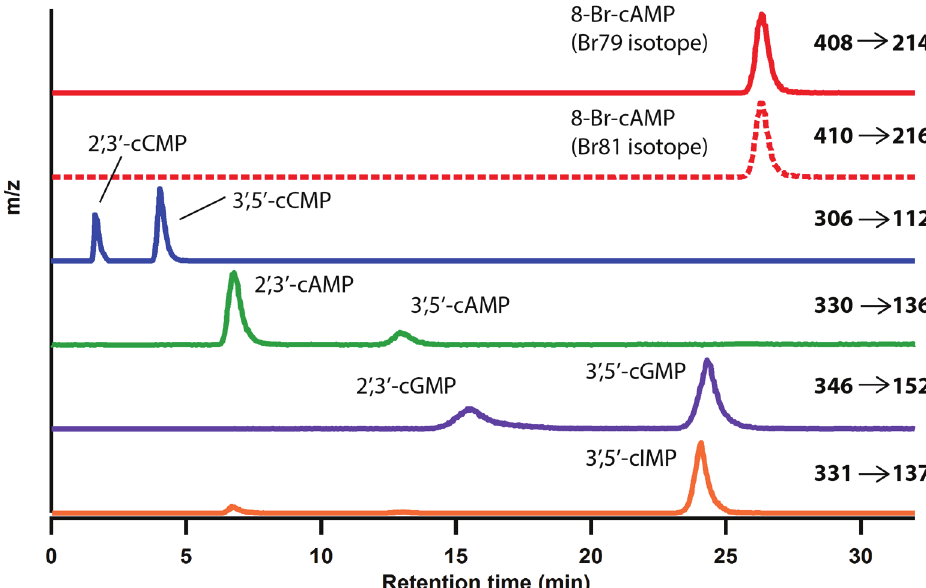
Figure 1. Reconstructed ion chromatogram of authentic cNMPs using Xcalibur software. From top to bottom, transition 408 (cid:2) 214 m/z was monitored and reconstructed for 79 Br-cAMP (Top, red trace) and transition 410 (cid:2) 216 m/z was monitored and reconstructed for 81 Br-cAMP (dotted red trace); transition 306 (cid:2) 112 m/z was monitored and reconstructed for 2',3'-cCMP and 3',5'-cCMP (blue trace); transition 330 (cid:2) 136 m/z was monitored and reconstructed for 2',3'-AMP and 3',5'-cAMP (green trace); transition 346 (cid:2) 152 m/z was monitored and reconstructed for 2',3'- cGMP and 3',5'-cGMP (purple trace); transition 331 (cid:2) 137 m/z was monitored and reconstructed for 3',5'-cIMP (orange